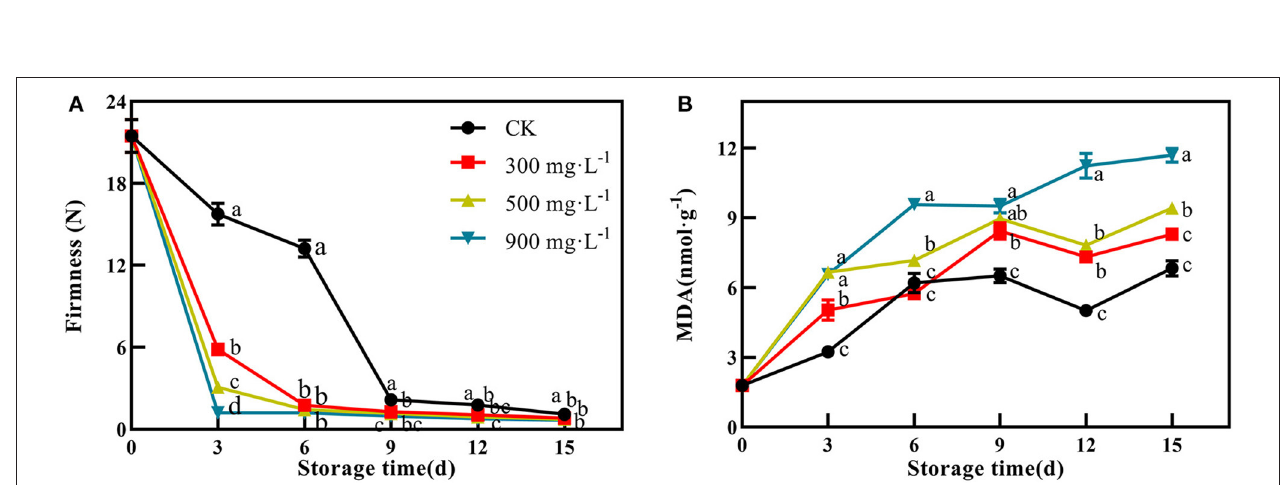
FIGURE 2 | Effects of ETH treatment on firmness (A) and MDA content (B) . Values followed by different letters are significantly different based on Duncan’s multiple range tests at P < 0.05. The error bars indicate the standard deviations of three biological replicates.